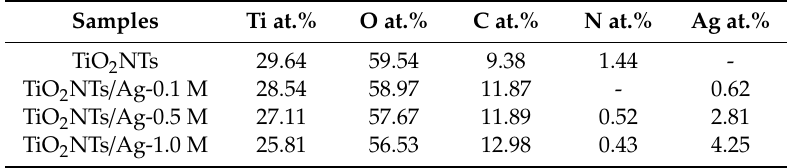
Table 1. The surface Ti, O, C, N and Ag atomic concentrations determined by XPS for TiO 2 NTs and TiO 2 NTs/Ag samples.